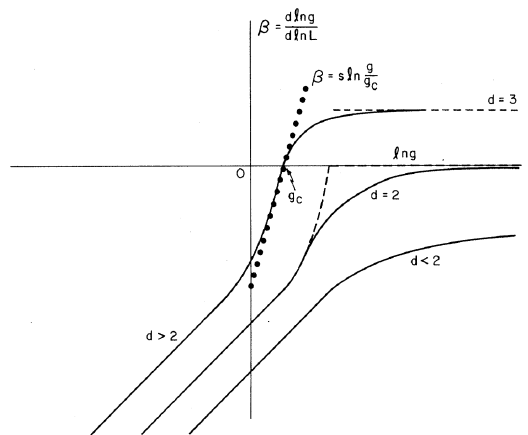
Figure 4. The scaling function β ( g ) against the dimensionless conductance g = 2¯ hG dimensions. From Ref. [98]. (Reprinted figure with permission from E. Abrahams, P.W. Anderson, D.C. Licciardello, and T.V. Ramakrishnan, Phys. Rev. Lett. 42, 673 (1979). Copyright (1979) by the American Physical